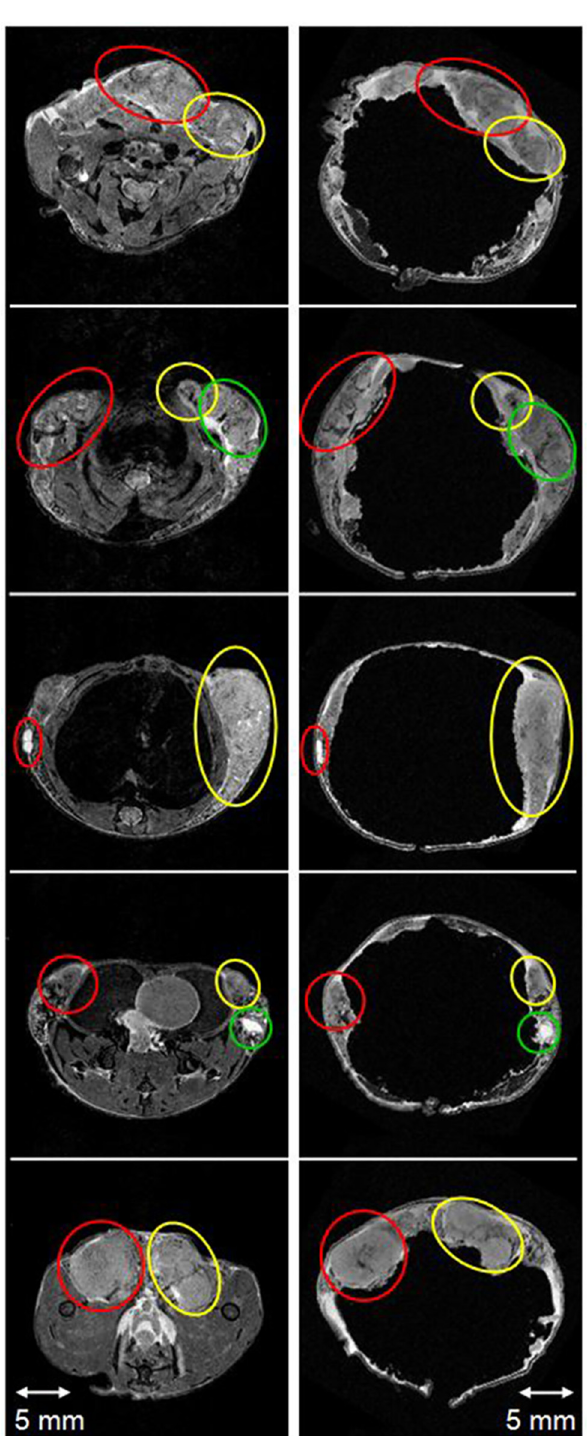
Fig 2. T2W in vivo image (left panel) matched with the corresponding ex vivo image (right panel) showing a mouse mammary gland from head to tail (top to bottom) – near the neck, heart, liver, below the kidney, and near the legs, respectively. Matching features (all invasive cancers) in the in vivo and ex vivo images, identified by visual inspection, were circled with the same color. The displayed image FOV is 25.6 × 25.6